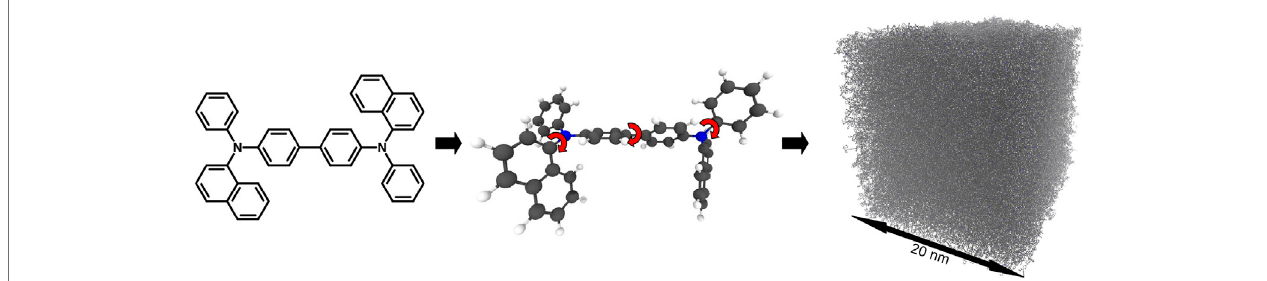
FIGURE 12 | Thin fi lm deposition simulation on the example of N,N ′ -Di(1-naphthyl)-N,N ′ -diphenyl-(1,1 ′ -biphenyl)-4,4 ′ -diamine (NPB): (i) Parametrizer: The molecular geometry gets optimized at the def2-TZVP/b3-lyp level with Turbomole. For the fi nal geometry partial charges are calculated with an ESP fi t. (ii) Dihedral-